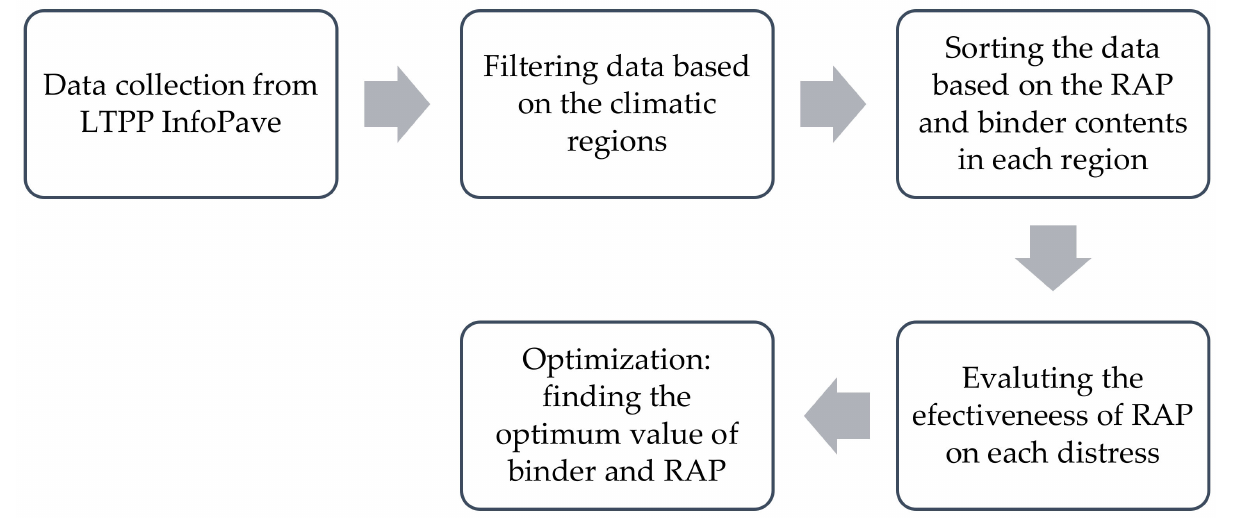
Figure 1. Flowchart of the research